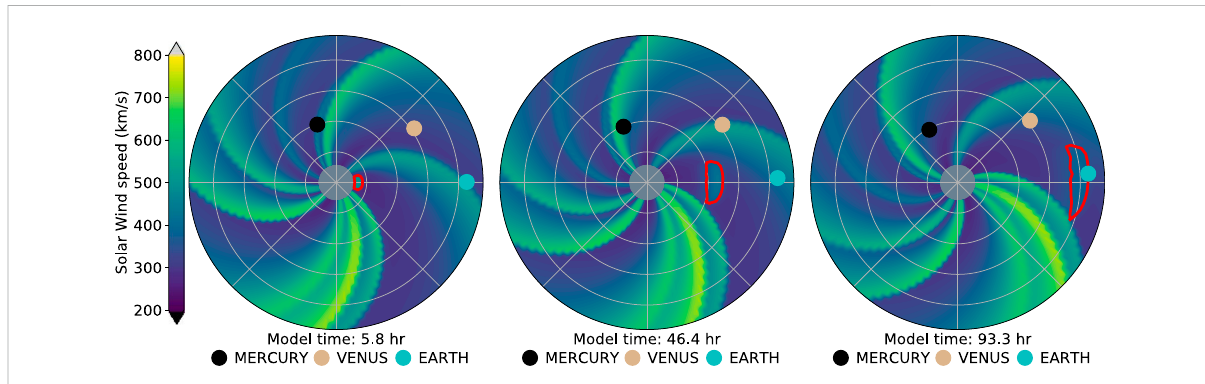
Snapshots a HUXt solution including a cone CME. The ambient solar wind boundary condition was taken from MAS for Carrington rotation 2254, as in Figure 6, while theCone CME parameters represent a climatologicallyaverage CME.From left to right, thepanels show theCone CME (in red) shortly after initiation, halfway through its transit to Earth, an on arrival at